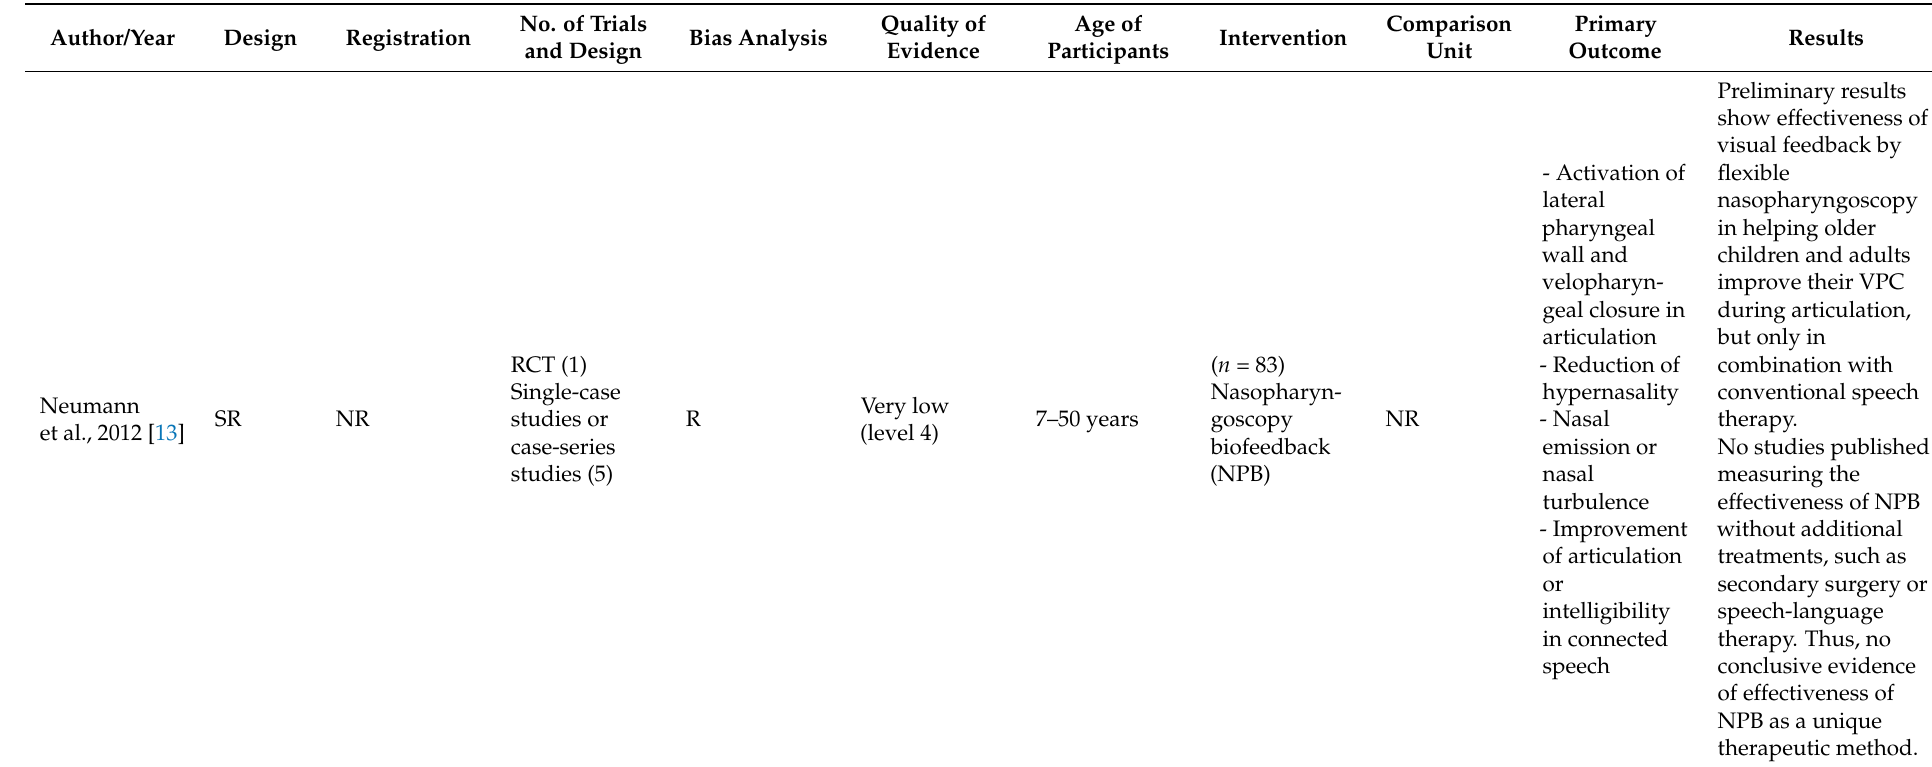
Table 3. Non-invasive